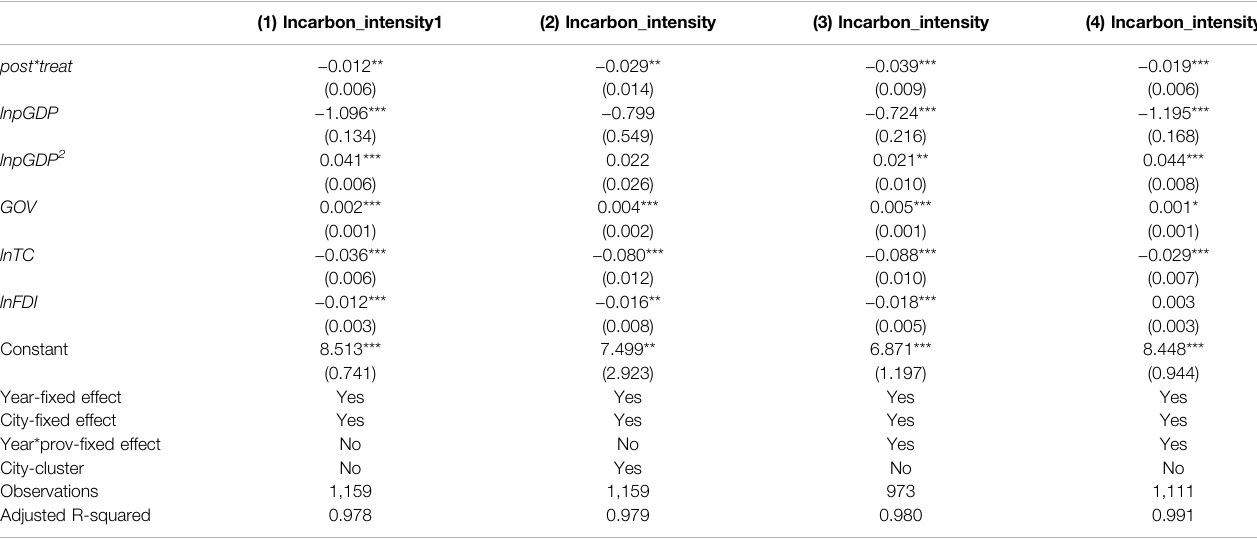
TABLE 7 | Variable replacement, sample selection, and model